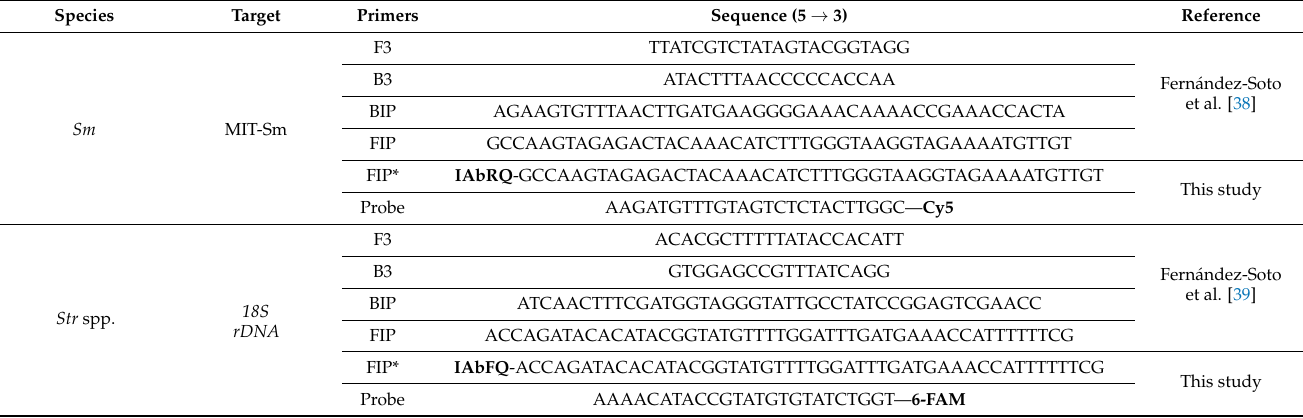
Table 1. LAMP primer and probe